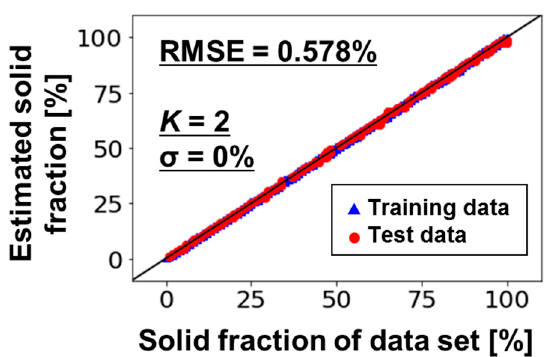
Figure 5. Results of solid–liquid phase fraction analysis by K -nearest neighbor algorithm (KNN) for the simulated spectral dataset without Gaussian errors ( σ = 0%) for both the training and testing data.